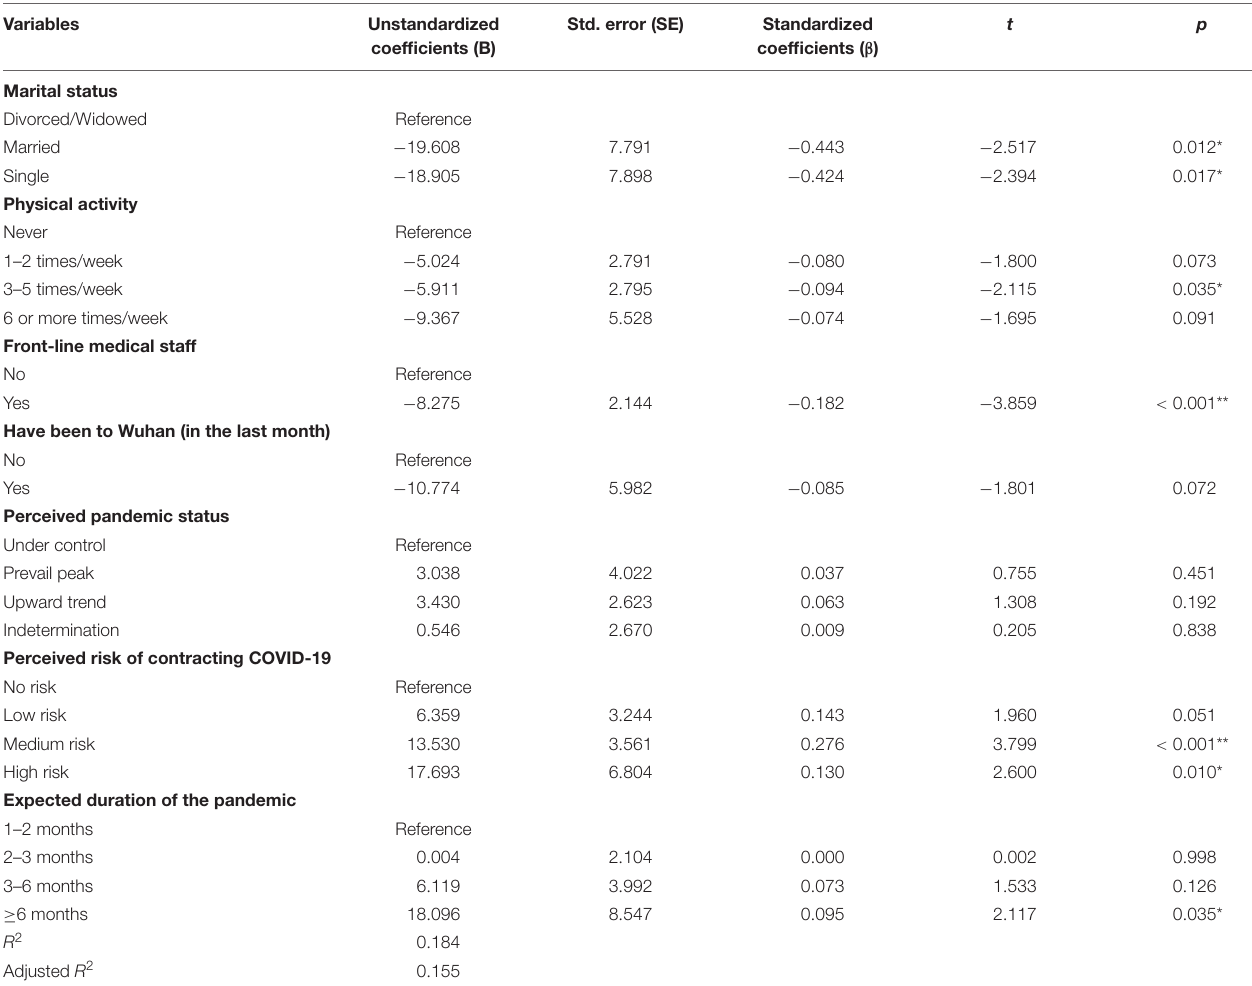
TABLE 3 | Multiple linear regression analysis of the influencing factors of acute stress